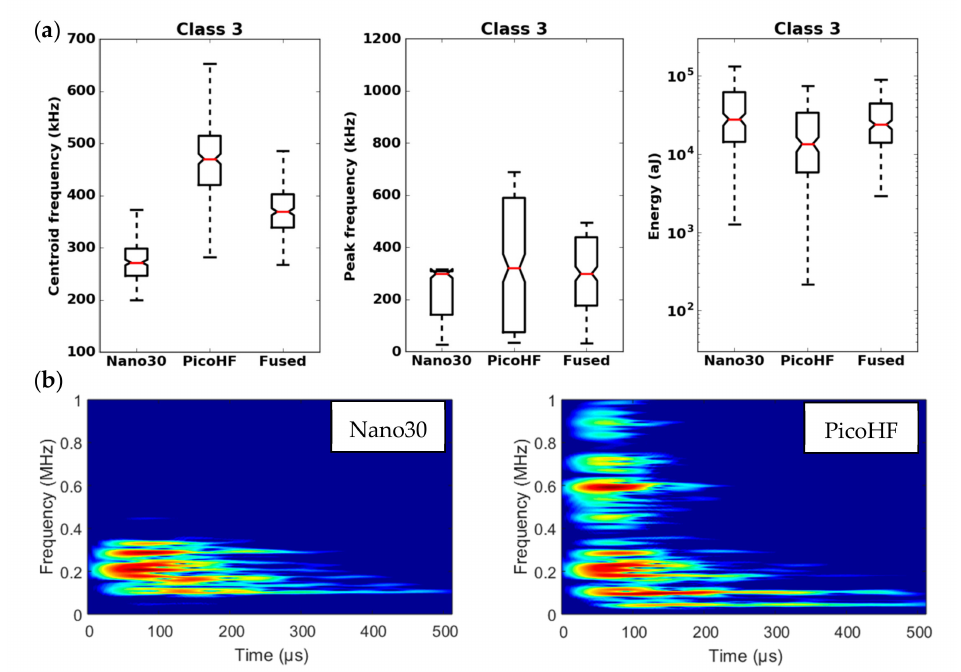
Figure 19. Results of the classification with an unsupervised classification based on fused features. ( a ) Characteristics of class 3 (frequency centroid, peak frequency and energy) viewed by the Nano30 sensor, PicoHF or with merged descriptors. ( b ) Representation in time / frequency domain with the SPWVD of the same AE signal recorded by Nano30 sensor and PicoHF sensor for class 3.